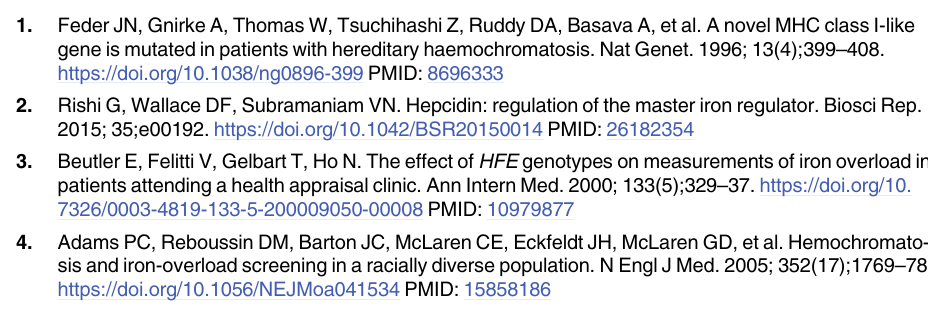
S1 Table. Characteristics of non-Hispanic white post-screening clinical examination par- ticipants with iron overload phenotypes. S2 Table. 58 non-Hispanic white post-screening clinical examination participants with iron overload phenotypes. S3 Table. Post-screening clinical examination participants with serum ferritin > 1000 μ g/L and elevated transferrin saturation without HFE